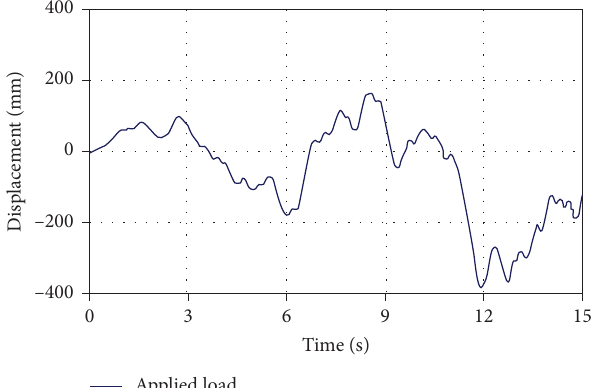
Figure 13: Loading history.